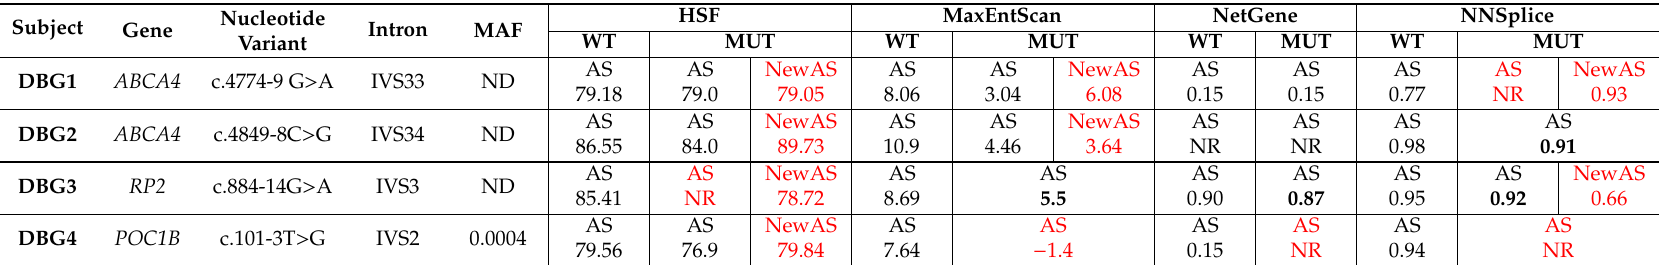
Table 3. In silico analysis of the identified variants altering Non-Canonical Splice Sites (NCSS), Gene, Location and Minimum Allele Frequency (MAF) of each variant is indicated. Relevant changes are highlighted in